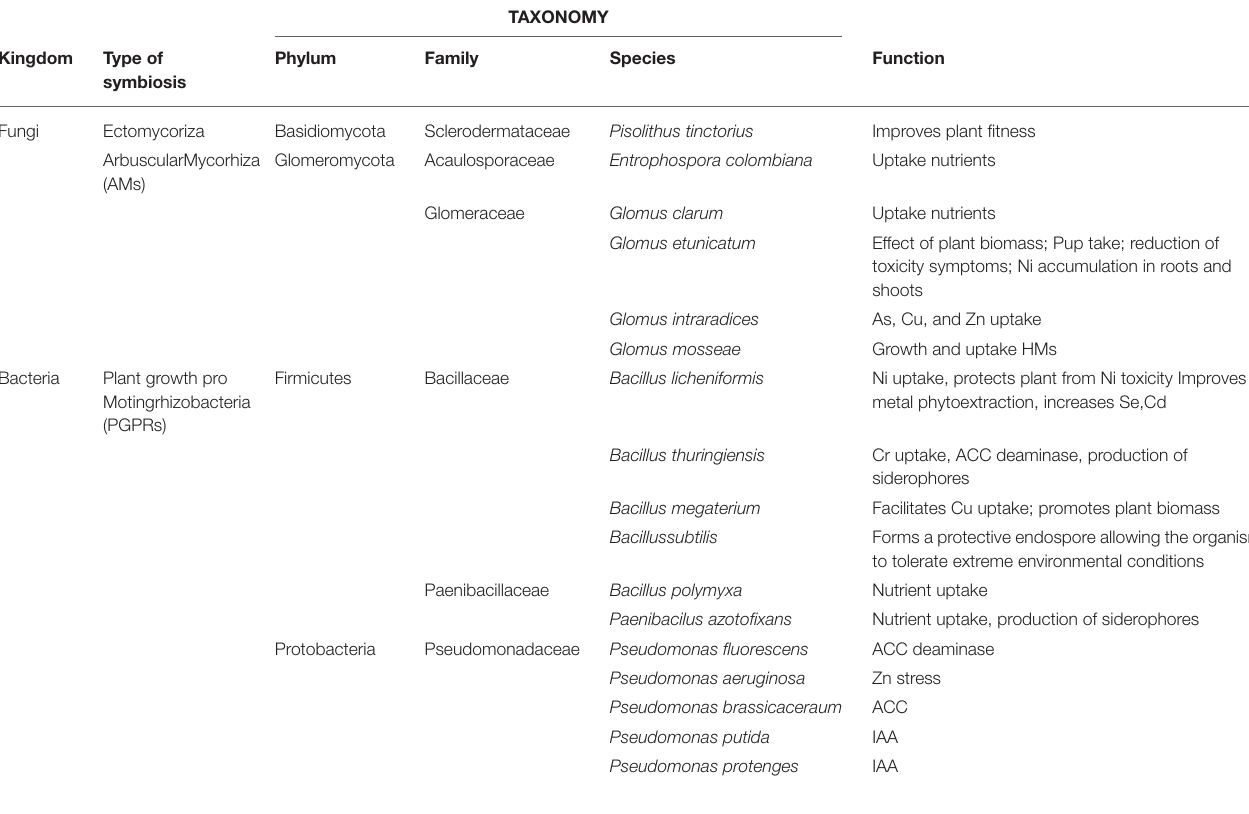
TABLE 1 | The rhizosphere microflora consortium